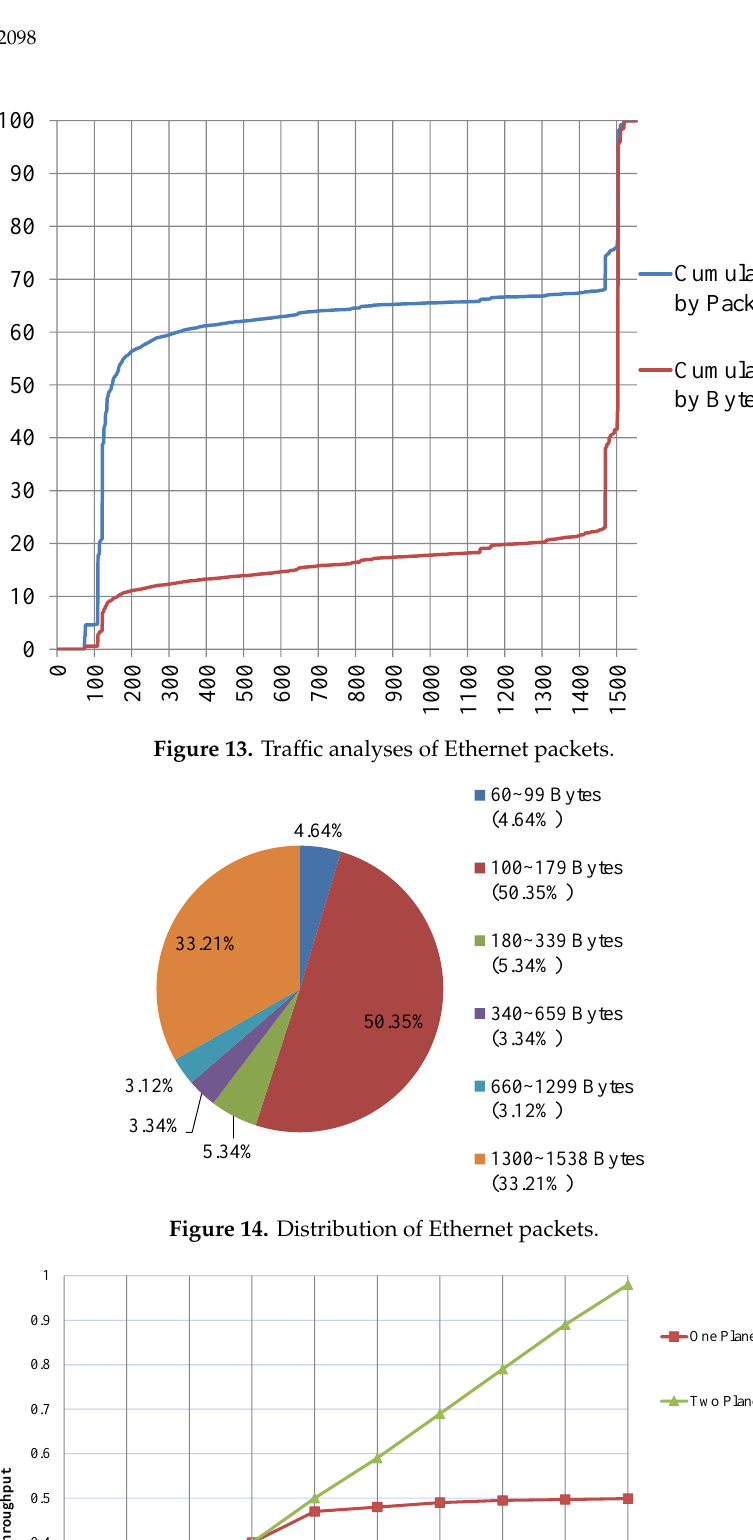
Figure 14. Distribution of Ethernet packets.